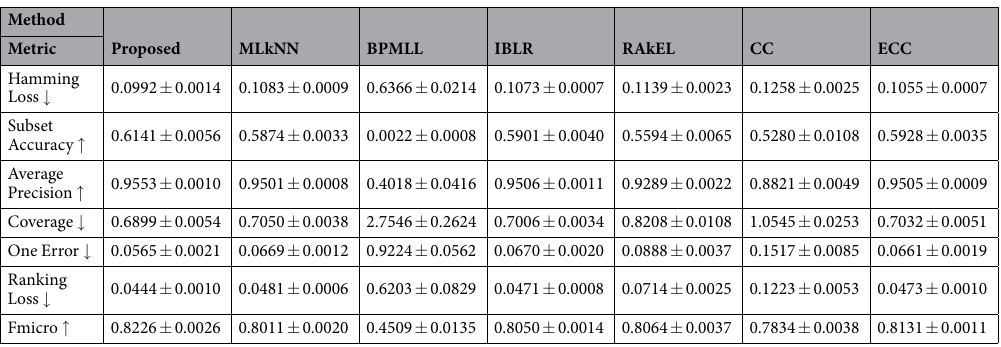
Table 6. Metric values of different multi-label learning methods through 5-CV on the filtered dataset. ↓ means lower is better; ↑ means higher is better.